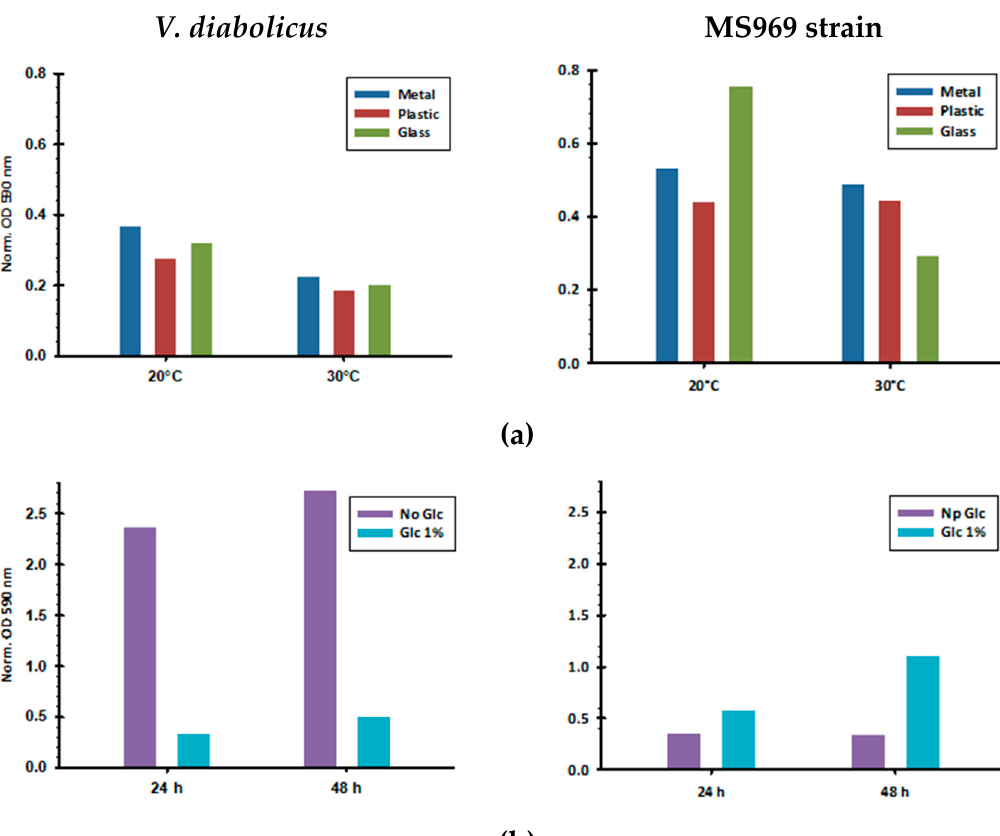
Figure 2. 16S rDNA sequence-based phylogenetic analysis of the MS969 strain.